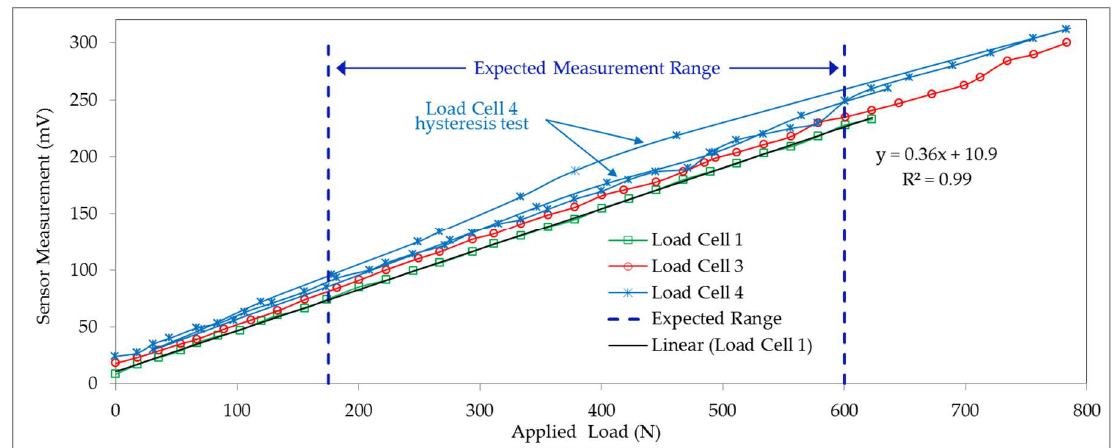
Figure 3 . Force Board characterization results indicating linearity, repeatability and